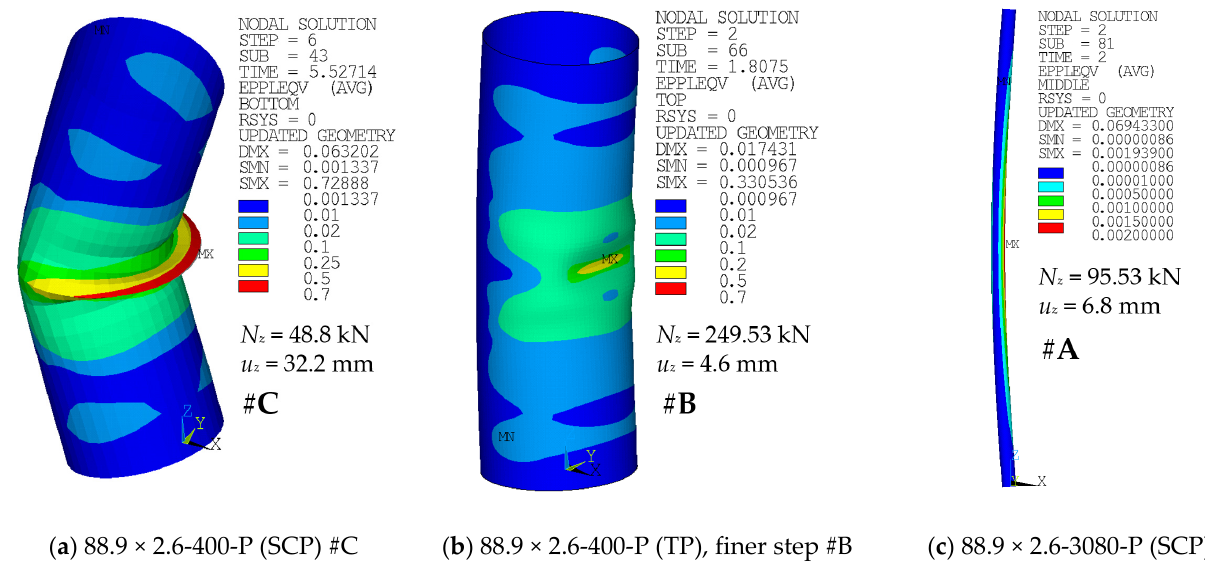
Figure 12. Equivalent plastic strain of various cases: ( a ) #C (SCP) curve from Figure 4; ( b ) #B (TP), finer step curve from Figure 4; and ( c ) #A (SCP) curve from Figure 6.